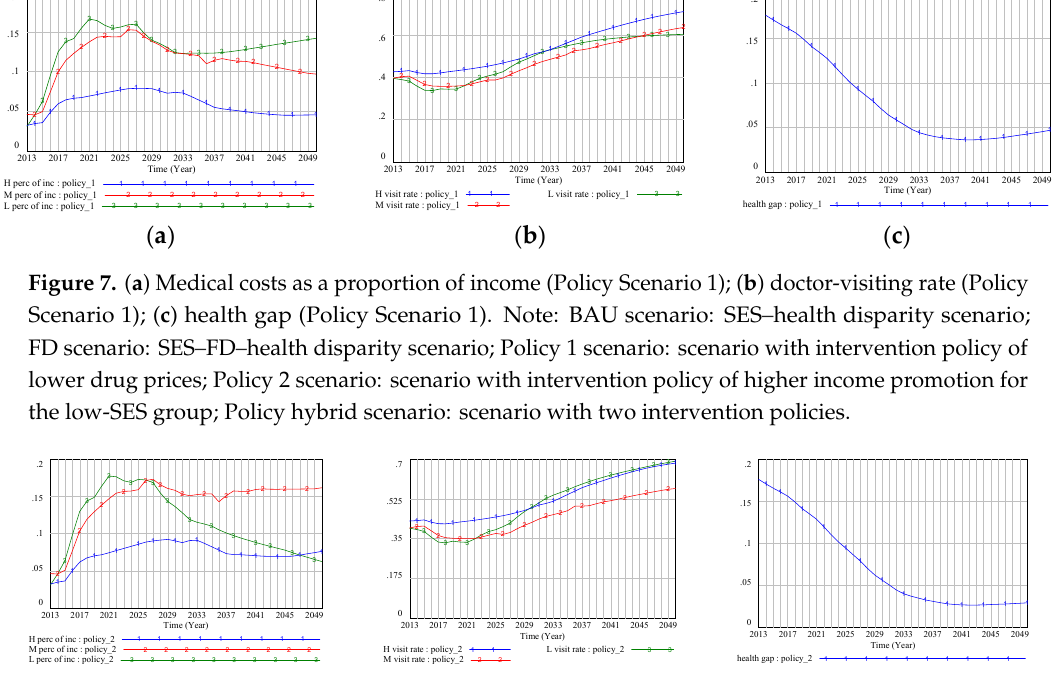
( b ) Figure 6. ( a ) Medical costs as a proportion of income (BAU scenario); ( b ) medical costs as a proportion of income (FD scenario). Note: BAU scenario: SES–health disparity scenario; FD scenario: SES–FD– health disparity scenario; Policy 1 scenario: scenario with intervention policy of lower drug prices; Policy 2 scenario: scenario with intervention policy of higher income promotion for the low-SES group; Policy hybrid scenario: scenario with two intervention policies. 3.2. Supporting Policy Intervention Simulation After the FD policy intervention, the proportion of income spent on medical costs remained high, resulting in the rebound of the health gap, which was our primary area of concern. Thus, we introduced two supporting policy interventions: lower drug prices and a higher income level for the low-SES group. We found that the measure to decrease medical costs would have little effect on reducing health disparity. The policy of lowering drug prices reduced medical costs for all SES groups, but it did not have a significantly stronger effect for the lower-SES groups. Thus, the disparity in the percentage of income spent on medical costs among different SES groups remained apparent. This percentage was projected to reach its lowest value for the low-SES group in 2036 (12.31%); afterwards, the percentage was projected to continually increase, while it decreased for the other groups (Figure 7a). However, the rate of visiting a doctor when sick was projected to increase among all SES groups, with a great reduction in the gap between the different groups. From 2023 to 2045, the doctor-visiting rate of